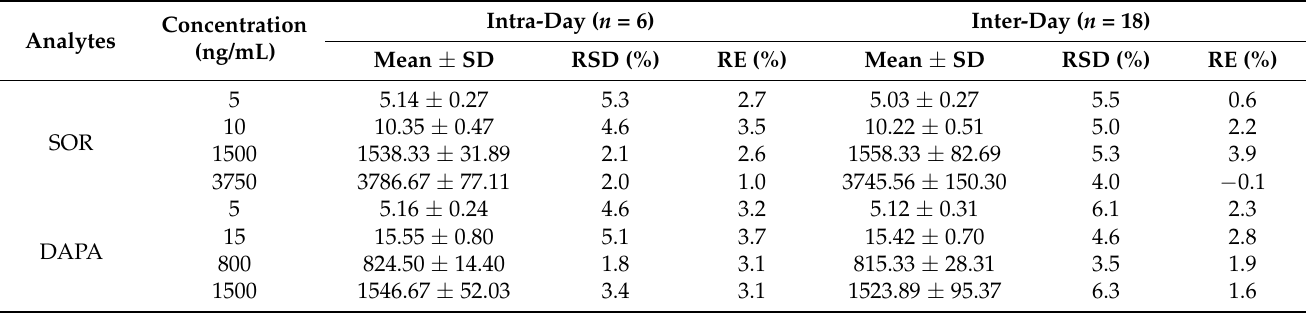
Table 1. Intra-day and inter-day precision and accuracy of SOR and DAPA in rat